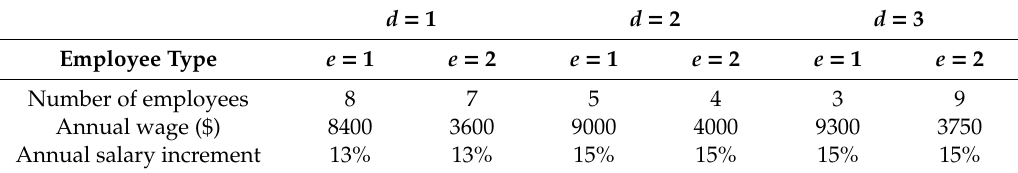
Table 6. Labor type, number, cost, and, wage increment at each distribution center.